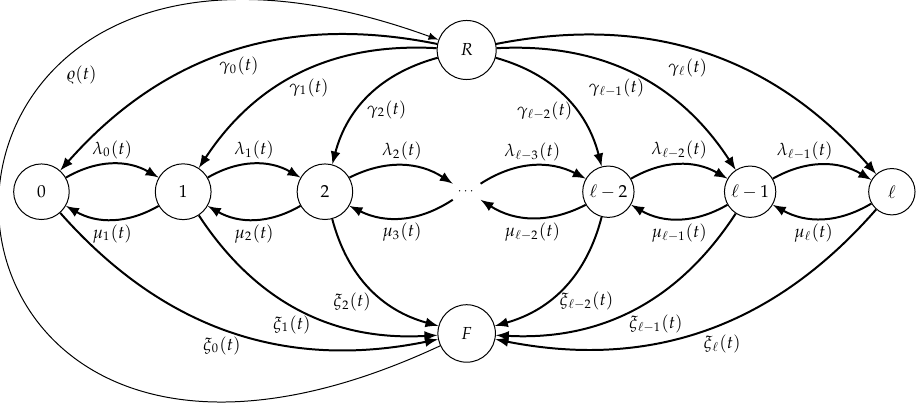
Figure 1. The state diagram of the Markov process N ( t ) modeling failures and